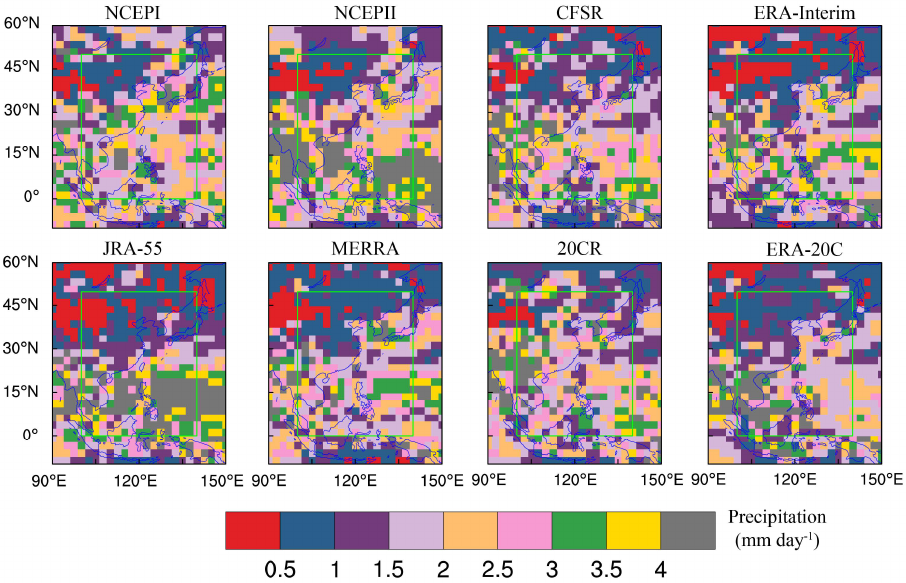
Figure 6. Root-mean-square error skill score for summer (June–July–August) rainfall during 1979–2010. The Global Precipitation Climatology Project (GPCP) is employed as the reference data for rainfall. The green box is the East Asian summer monsoon region (0–50 ◦ N, 100–140 ◦ E).